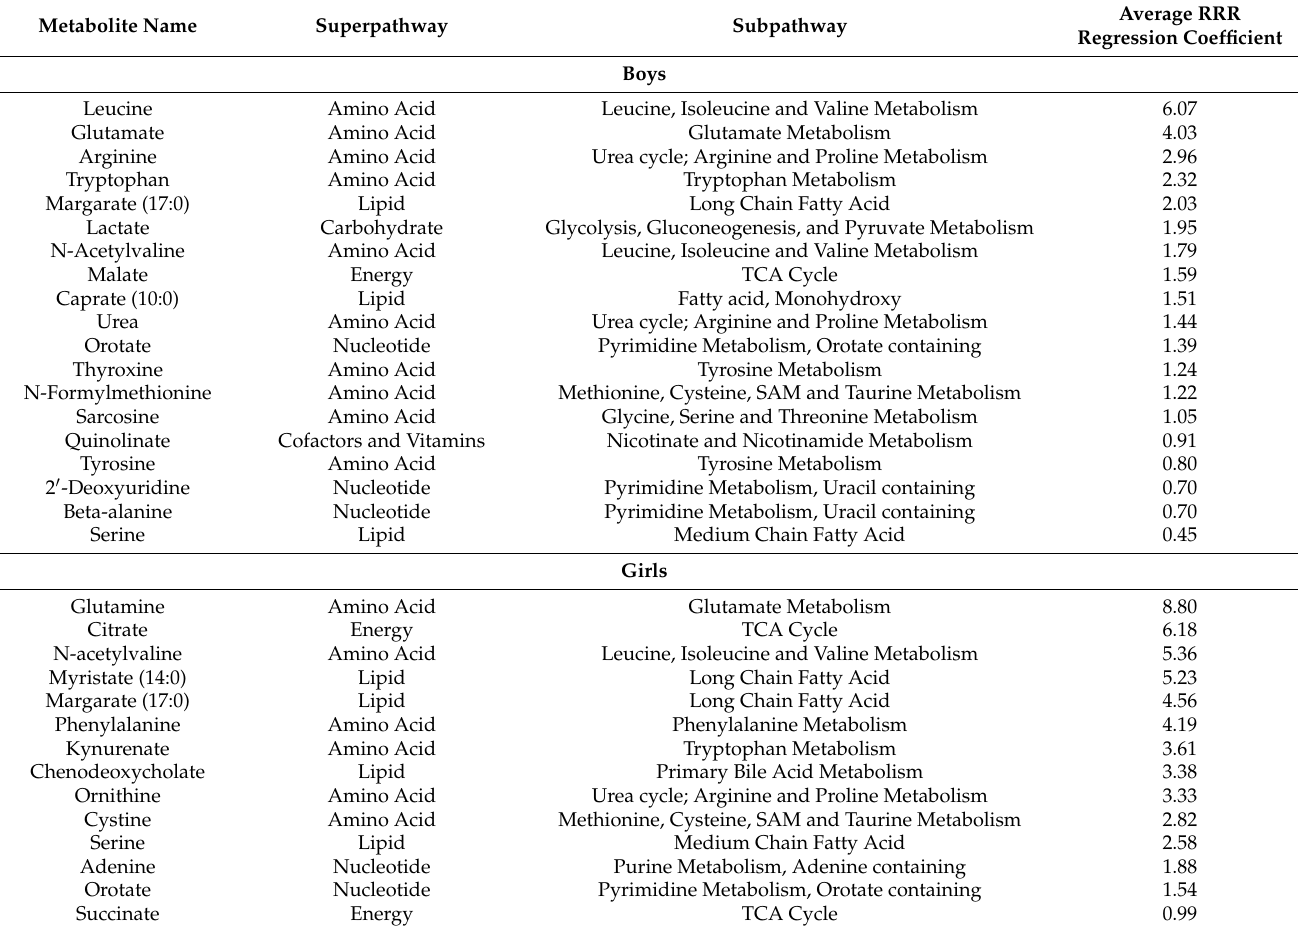
metabolism pathways. Table 2 displays metabolite identity and average RRR regression coefficients. Table S2 is a list of metabolites that were in the top 10% of RRR regressions coefficients during at least one of the five iterations. Table 2. Identity, superpathway, and subpathway of metabolites assayed from fasting blood at baseline (age ~10 y), selected as predictors of fasting glucose at follow-up (age ~16 y) using reduced rank regression (RRR) in the EPOCH